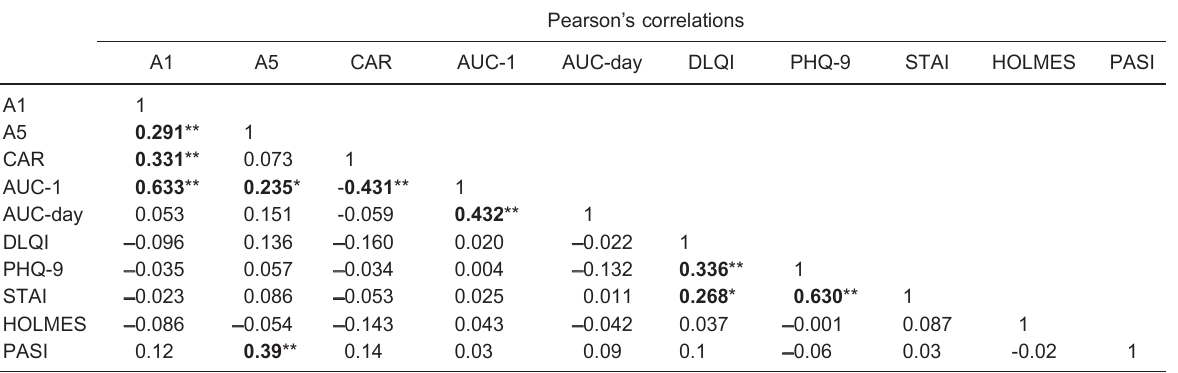
Table 3. Pearson’s correlations between psychopathological and salivary cortisol